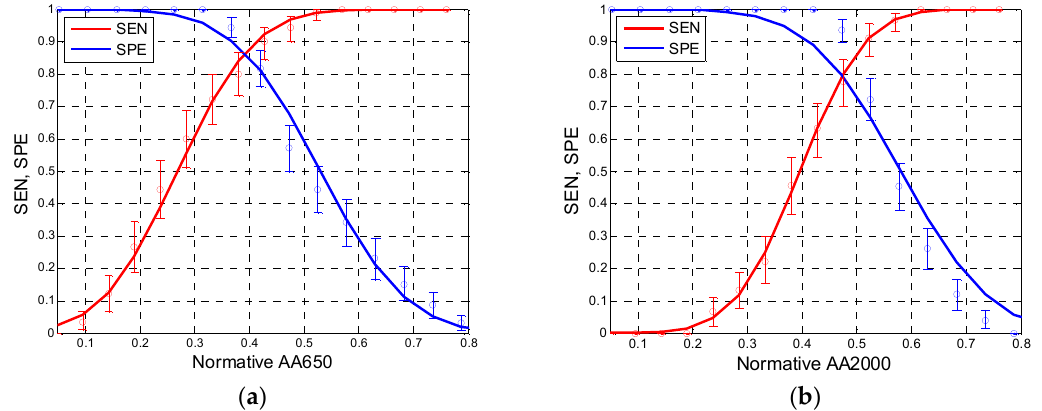
Figure 9. Sensitivity (SEN, red) and specificity (SPE, blue) of tests based on absorbance values for AA650 ( a ) and AA2000 ( b ) as test criteria. Lines show approximations to normal distribution functions (based on data from Figure 8). Whiskers denote 5–95% confidence intervals.